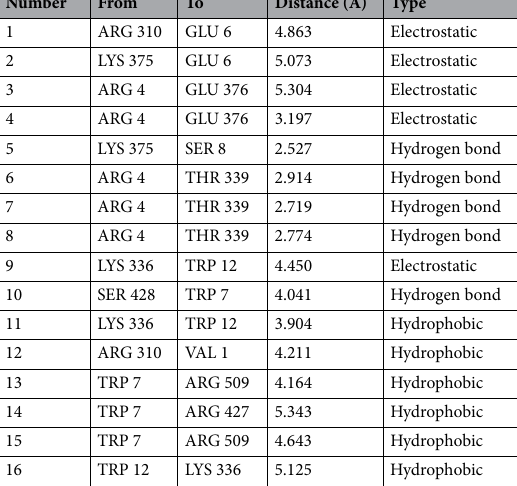
Number From To Distance (Å)